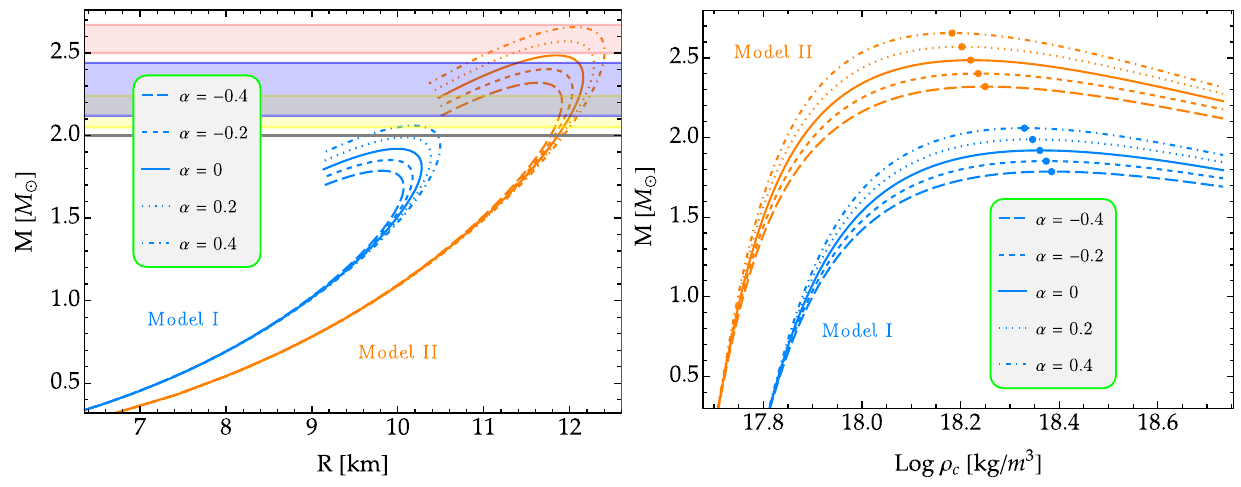
Fig. 3 Mass-radius diagram (left panel) and mass-central density rela- tion(rightpanel)foranisotropicdarkenergystarsaspredictedbymodel I (blue curves) and II (orange curves) with anisotropy profile (30) for several values of α . The colored bands in the left plot represent the same as in Fig. 1. Moreover, the full blue and orange circles on the right plot indicate the maximum-mass points for model I and II, respectively.